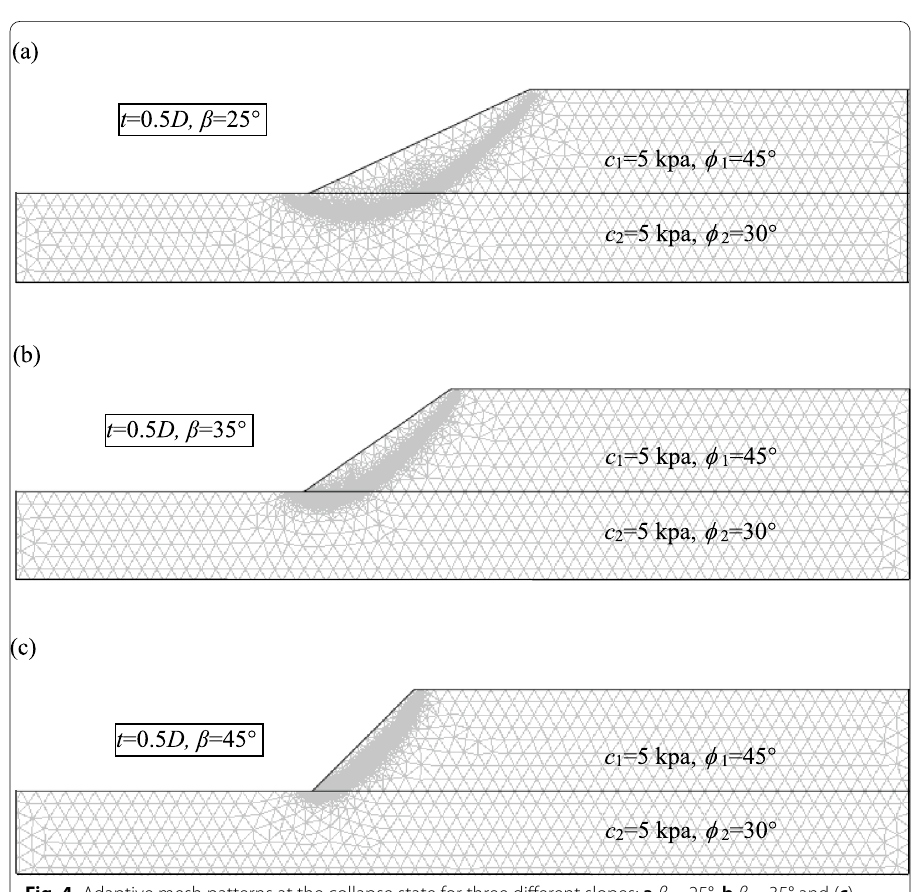
Fig. 4 Adaptive mesh patterns at the collapse state for three different slopes: a β β =